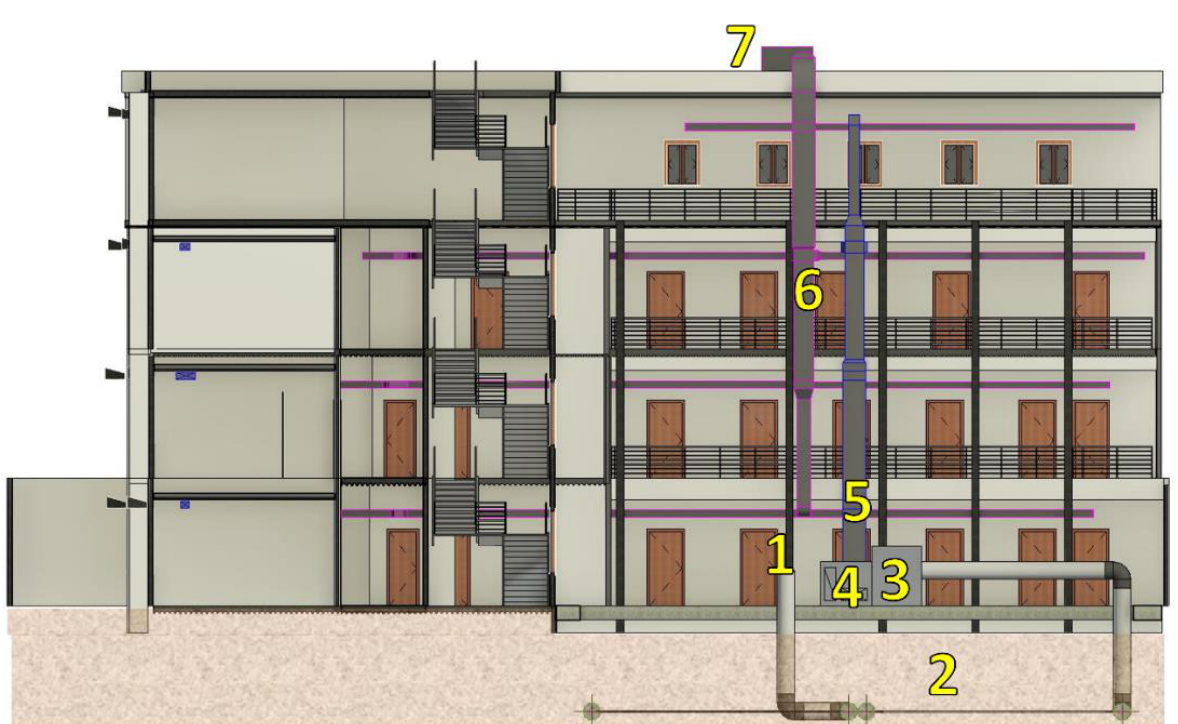
Figure 1. The working concept of the earth-to-air heat exchanger. Legend: 1, fresh air intake; 2, buried pipes (3 m depth); 3, fan; 4, air-handling unit fresh air supply; 5, supply air ducts (blue); 6, exhaust air ducts (pink); and 7, air-handling unit exhaust air extraction.